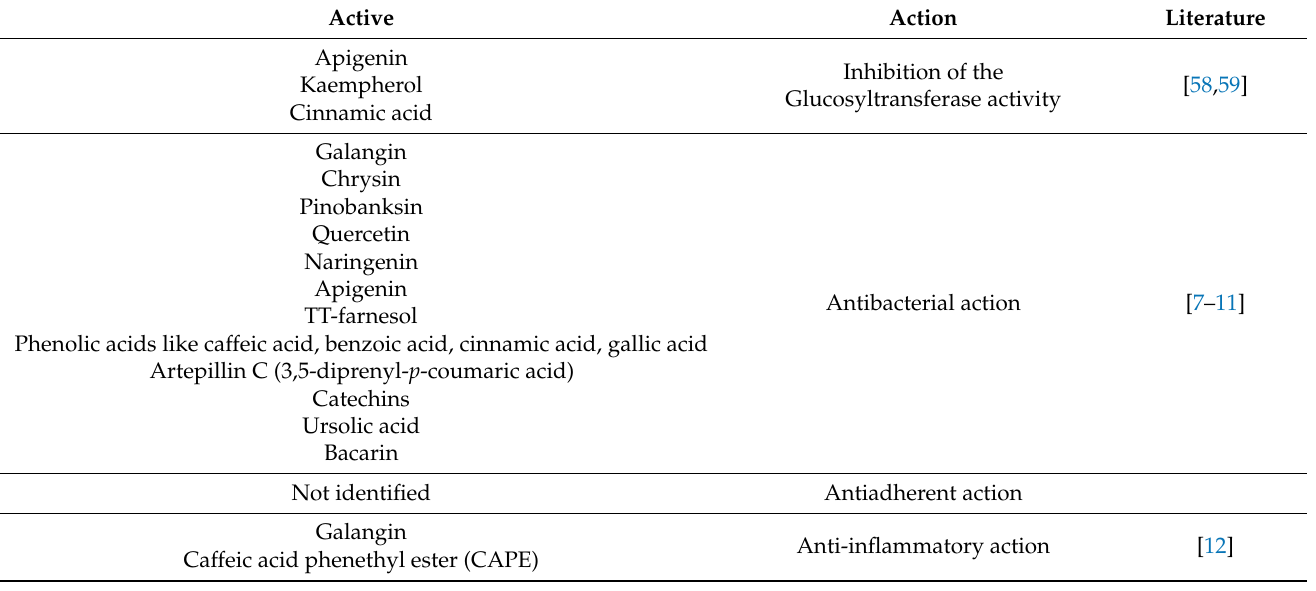
Table 1. Summarization of the action of propolis active components and correlation with their influence on the oral cavity